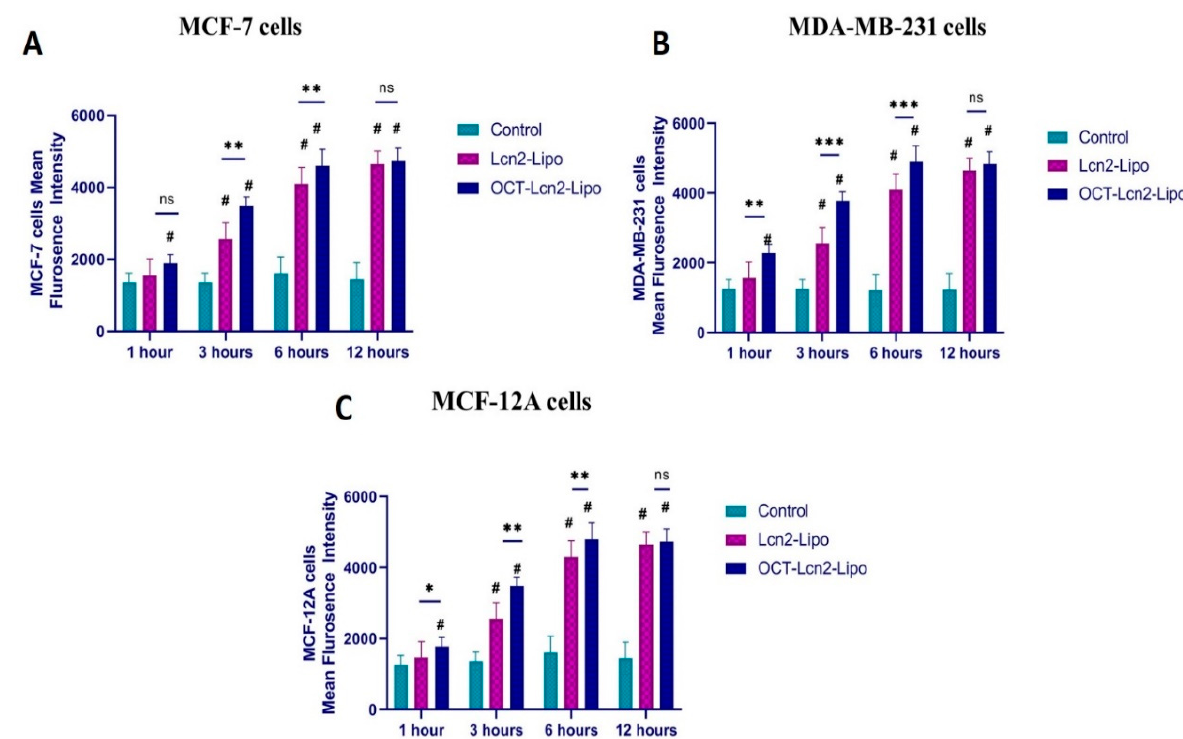
Figure 7. Time-dependent uptake of OCT-Lcn2-Lipo and Lcn2-Lipo prepared with the addition of FITC conjugated siRNA. ( A ) Uptake of OCT-Lcn2-Lipo and Lcn2-Lipo solution in MCF-7 cells, ( B ) Uptake of OCT-Lcn2-Lipo and Lcn2-Lipo solution in MDA-MB-231 cells. ( C ) Uptake of OCT-Lcn2-Lipo and Lcn2-Lipo solution in MCF-12A cells. The data were expressed as mean ± SD ( n = 3). (# p ≤ 0.05 as compared to control group, ** p ≤ 0.01 and *** p ≤ 0.001 as compared to Lcn2-Lipo group).